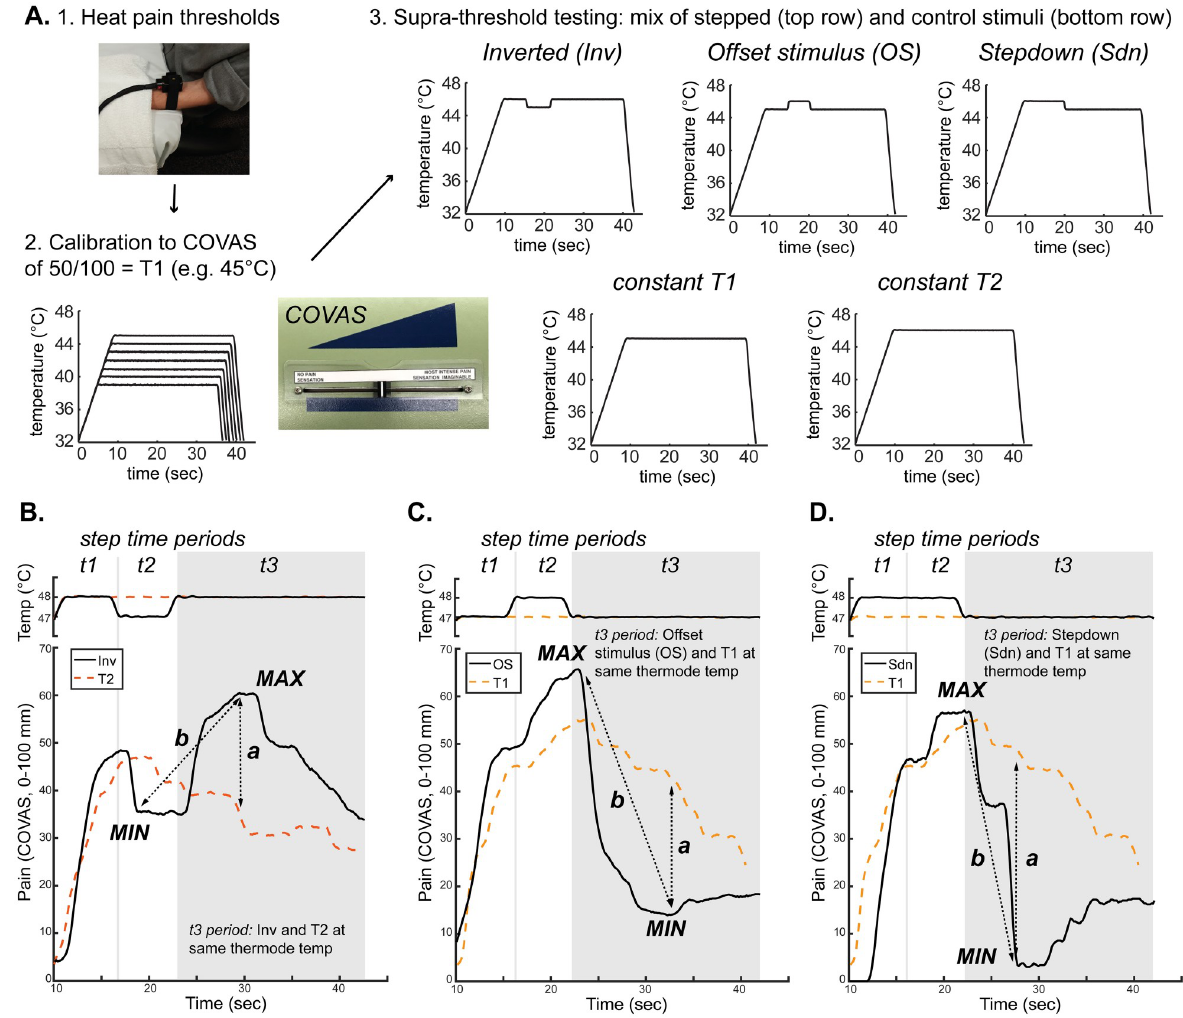
Fig 1. Experimental design and examples of data analysis. A. Subjects underwent (1) heat pain threshold testing, (2) an ascending series of suprathreshold, constant, 30-second, temperature stimuli to determine an individualized temperature that would elicit a COVAS pain rating of 50 mm/100 mm, and finally (3) a randomized mixture of suprathreshold, 30-second temperature stimuli testing the importance of direction of stimulus intensity change on pain perception. The mixture included transient, changing, supra-threshold noxious thermal stimuli (top row) and comparison constant stimuli (bottom row) shown. The data plotted are examples from a single subject in which T1 = 45˚C. B.–D. Examples of continuous pain intensity measured by COVAS and thermode temperature during stepped stimuli with appropriate control stimuli superimposed from a different single subject in which T1 = 47˚C. Inverted (Inv) stimulus data are plotted overlapping with the control T2 stimulus data to illustrate differences in subjective pain intensity produced by transient noxious thermal stimulus changes. During the t3 period (shaded area), both Inv and constant T2 stimuli are held at the same thermode temperature, differing by immediately preceding noxious thermal temperatures ( B ). In this subject, despite the same thermode temperature the reported pain intensity is higher during the t3 period for the Inv stimulus than for the constant control thermal stimulus. Similarly, offset stimulus ( C ) and stepdown ( D ) data are plotted with constant control T1 data to illustrate differences in pain intensity. Pain intensity changes are quantified in two ways. The first is a comparison between stepped and control stimuli (dotted arrows labeled “ a ”). For example in B , the a arrow shows the difference between the local maximum of the COVAS pain curve during the Inv stimulus and the pain intensity at the same timepoint during the control T2 stimulus. The second is a comparison made within a given stimulus (“ b ” arrows depict differences within the stepped stimuli between local maxima and minima of the COVAS pain curves). Differences between stepped and control stimuli ( a arrows) and within-stimulus changes during stepped stimuli ( b arrows) were extracted for group-level analysis.